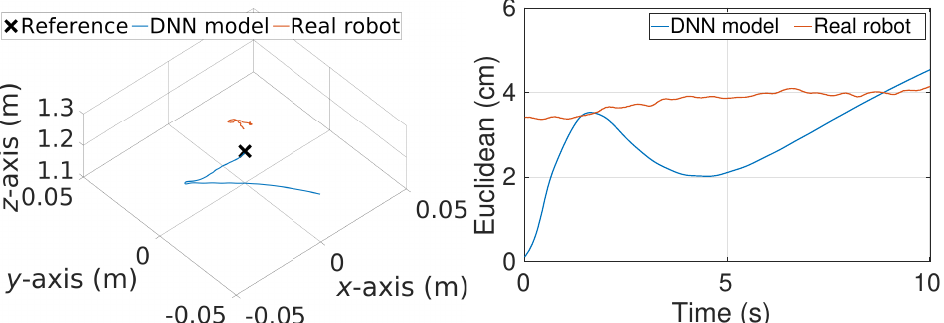
Figure 3. Hovering performance of the weight set obtained from simulation tuning. ( Left ): 3D view of the stationary reference and tracked trajectories. ( Right ): resulting Euclidean error over the DNN model and the real robot.